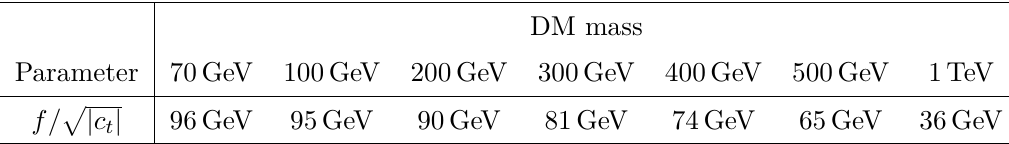
search strategy described in section T